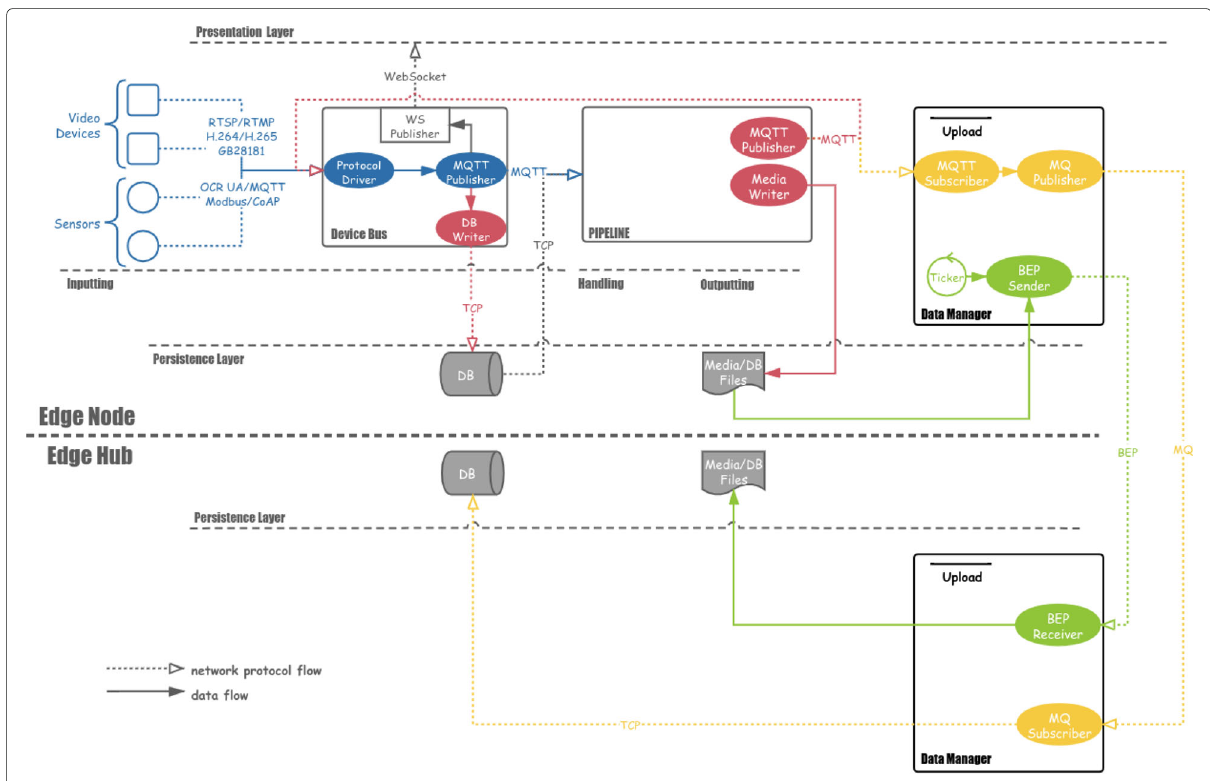
Fig. 5 Data flow in the Sophon Edge platform